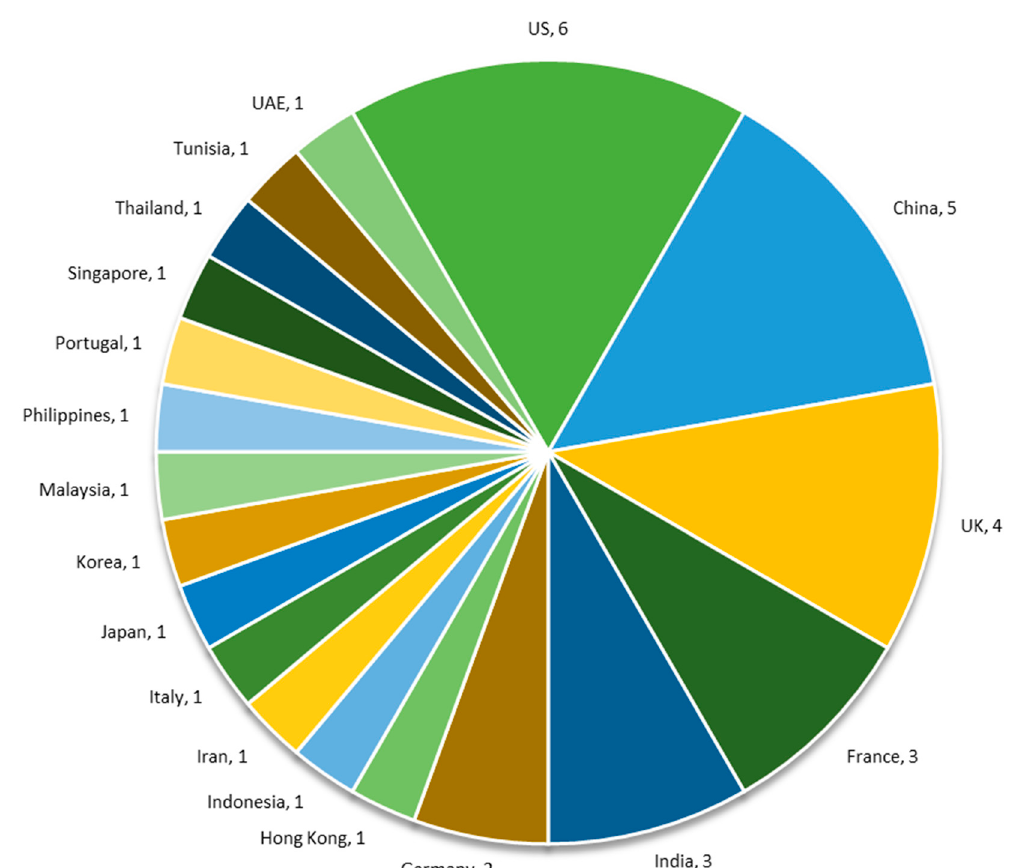
Figure 8. Stock market locations by country.